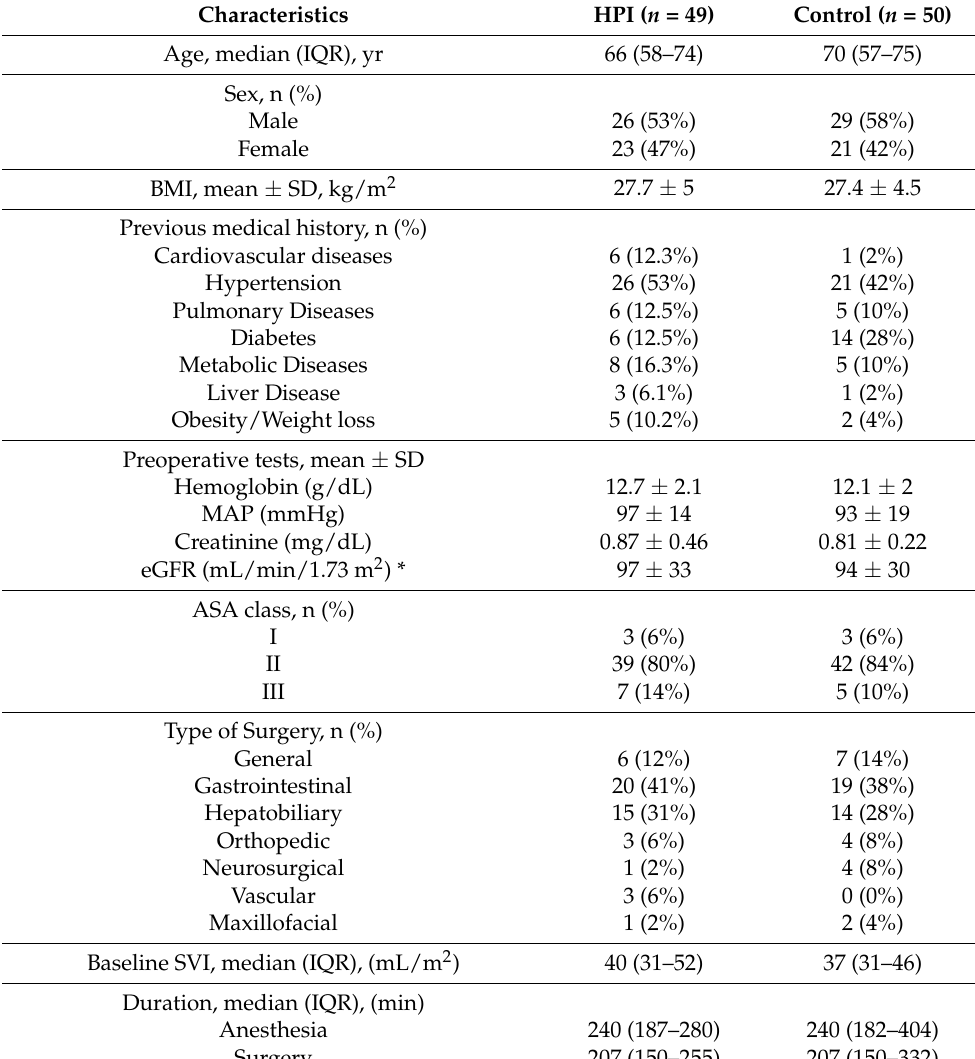
Table 1. Baseline